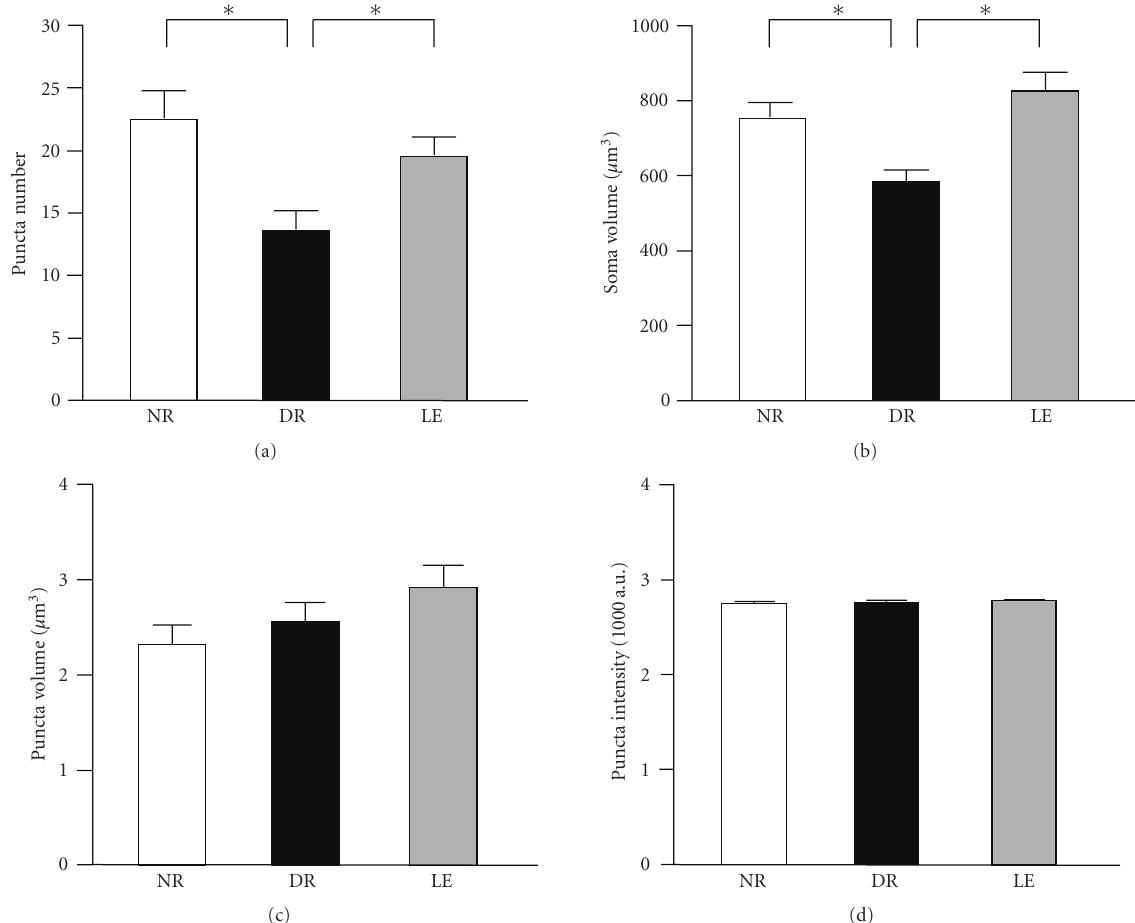
Figure 2: Visual experience bidirectionally changes the number of GAD65 puncta contacting the soma of pyramidal neurons in layer 2/3 of visual cortex without altering the size or intensity of GAD65 puncta. (a) Dark rearing from birth for 5 weeks (DR) significantly decreased the number of GAD65 puncta contacting neuronal soma compared to normal reared mice of equivalent age (NR). Exposing the dark reared mice to light for 3 days (LE) increased the number of GAD65 puncta close to NR levels. Asterisks indicate statistical significance of P < . 02 using a Fisher’s PLSD posthoc analysis following a one-way ANOVA. (b) The soma volume of YFP expression neurons in layer 2/3 used for measuring GAD65 puncta number. There was a statistically significant decrease in soma volume of DR mice compared to NR and LE groups. Asterisks: P < . 01 using a Fisher’s PLSD posthoc analysis following a one-way ANOVA. (c) Visual experience did not significantly alter the size of GAD65 puncta contacting the soma of layer 2/3 pyramidal cells. (d) There was no statistically significant di ff erence in the intensity of GAD65 puncta contacting the soma of layer 2/3 pyramidal cells across the three